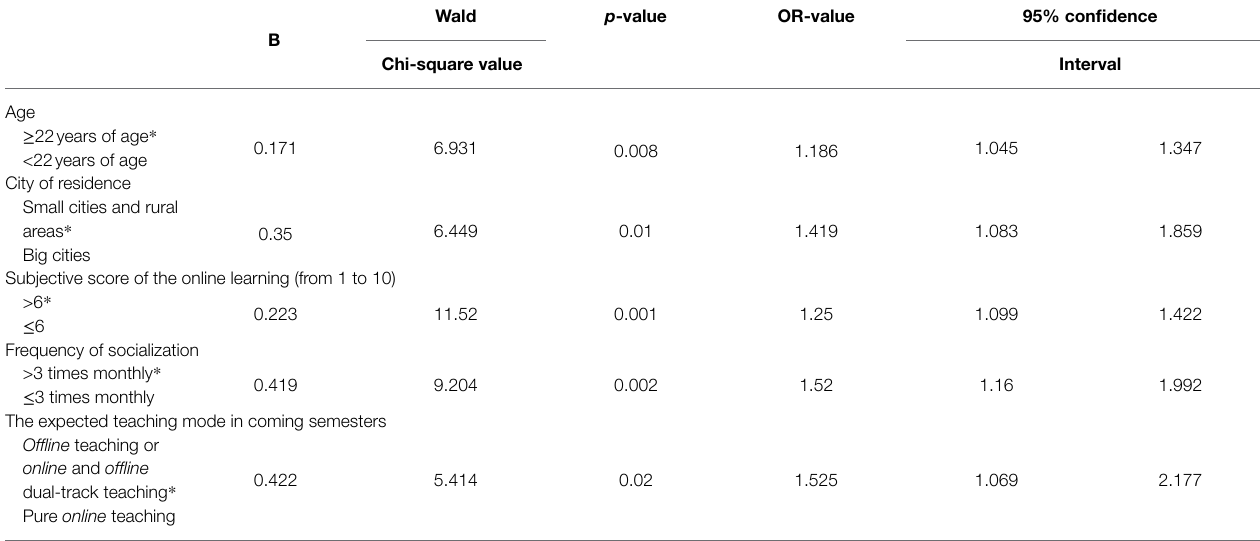
TABLE 3 | Logistic regression analysis of the incidence of anxiety during online courses for international students.